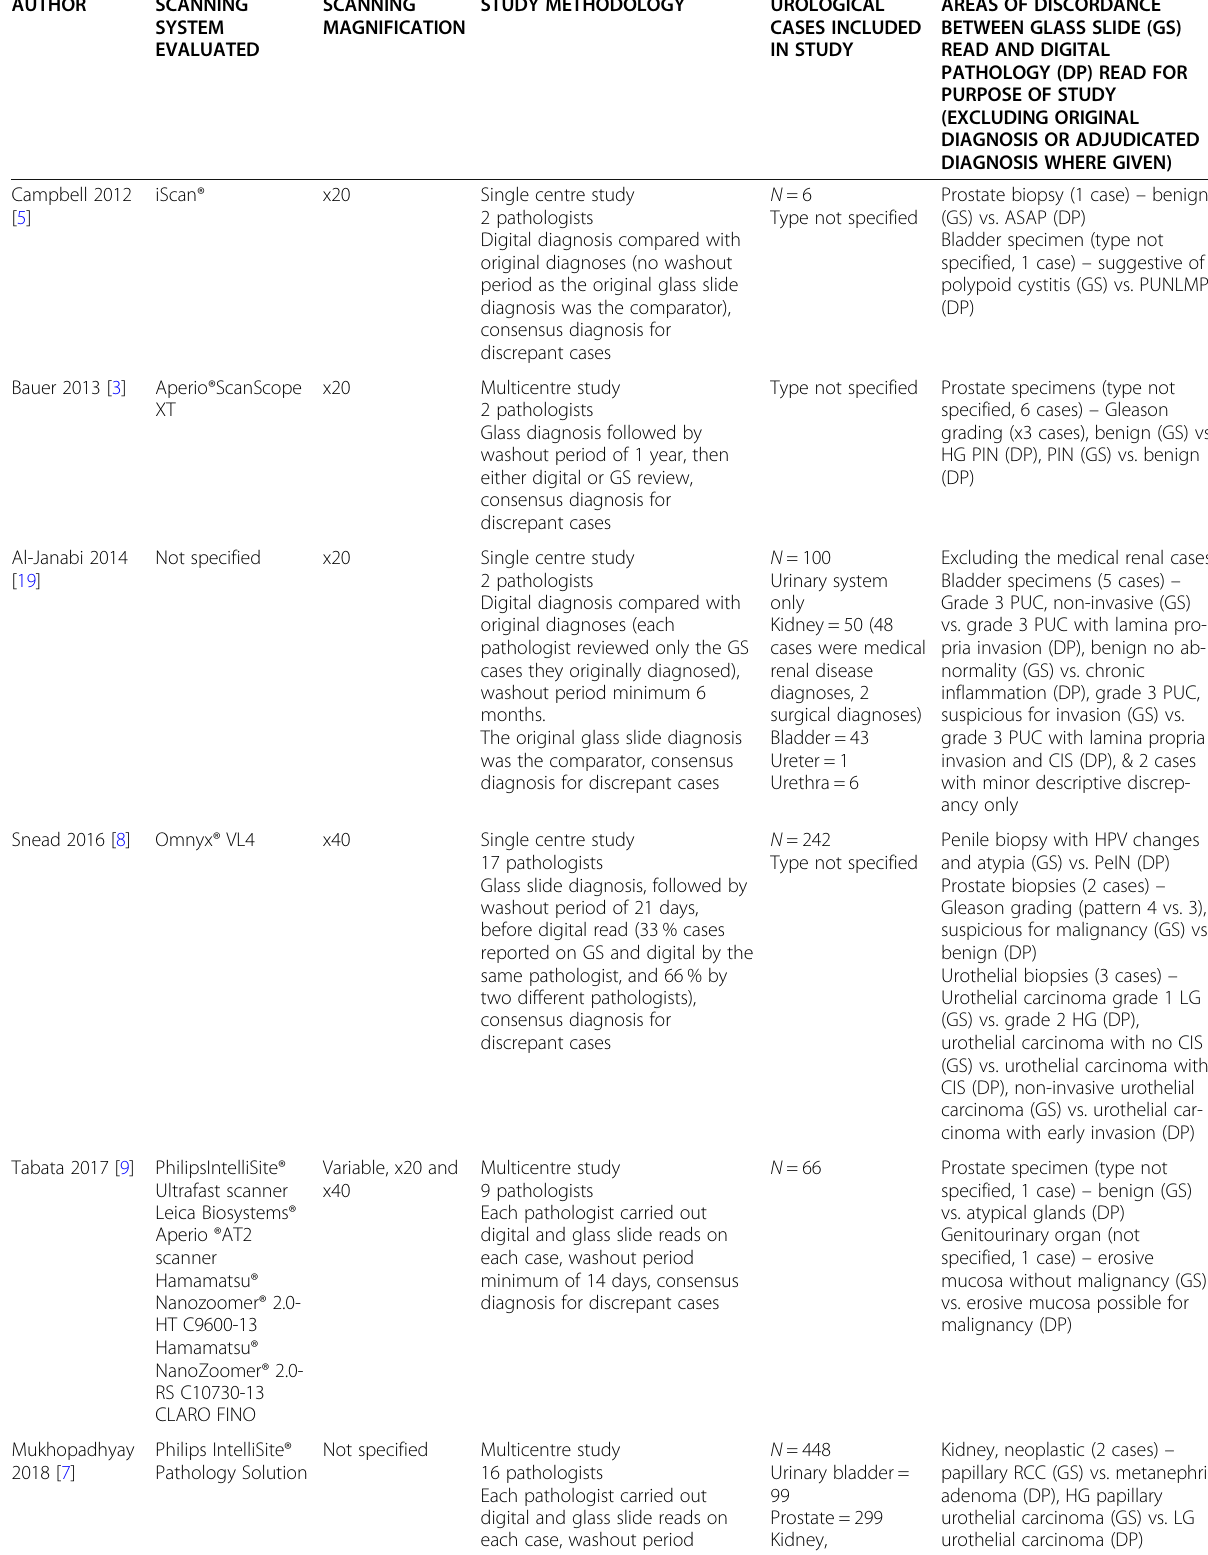
Table 2 Summary of major digital pathology validation studies which include urological